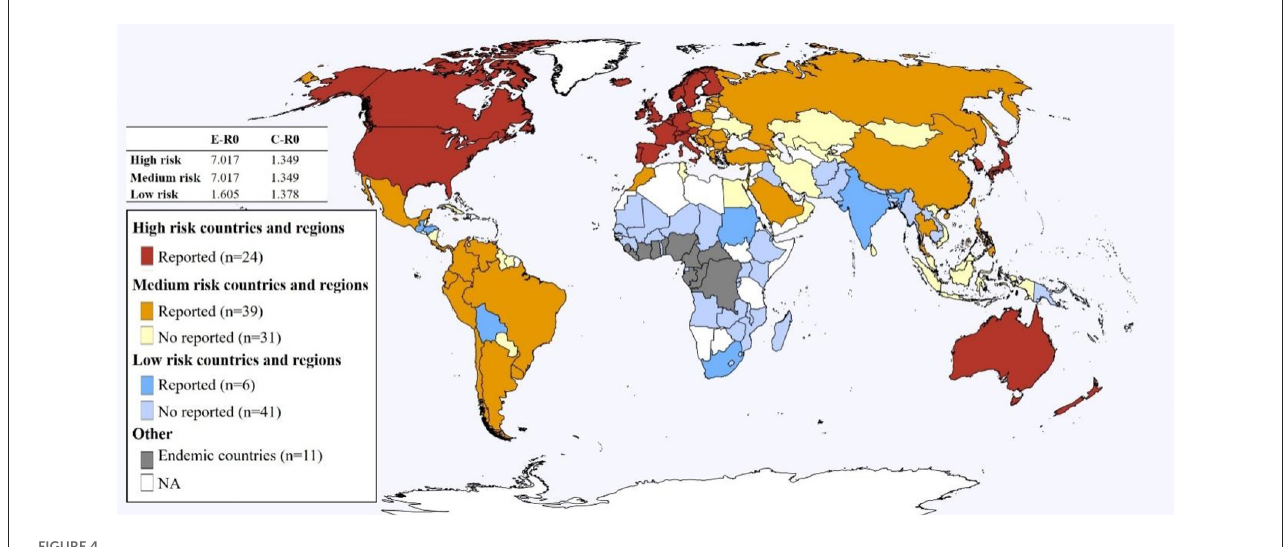
FIGURE4 Country classification based on key risk factors.